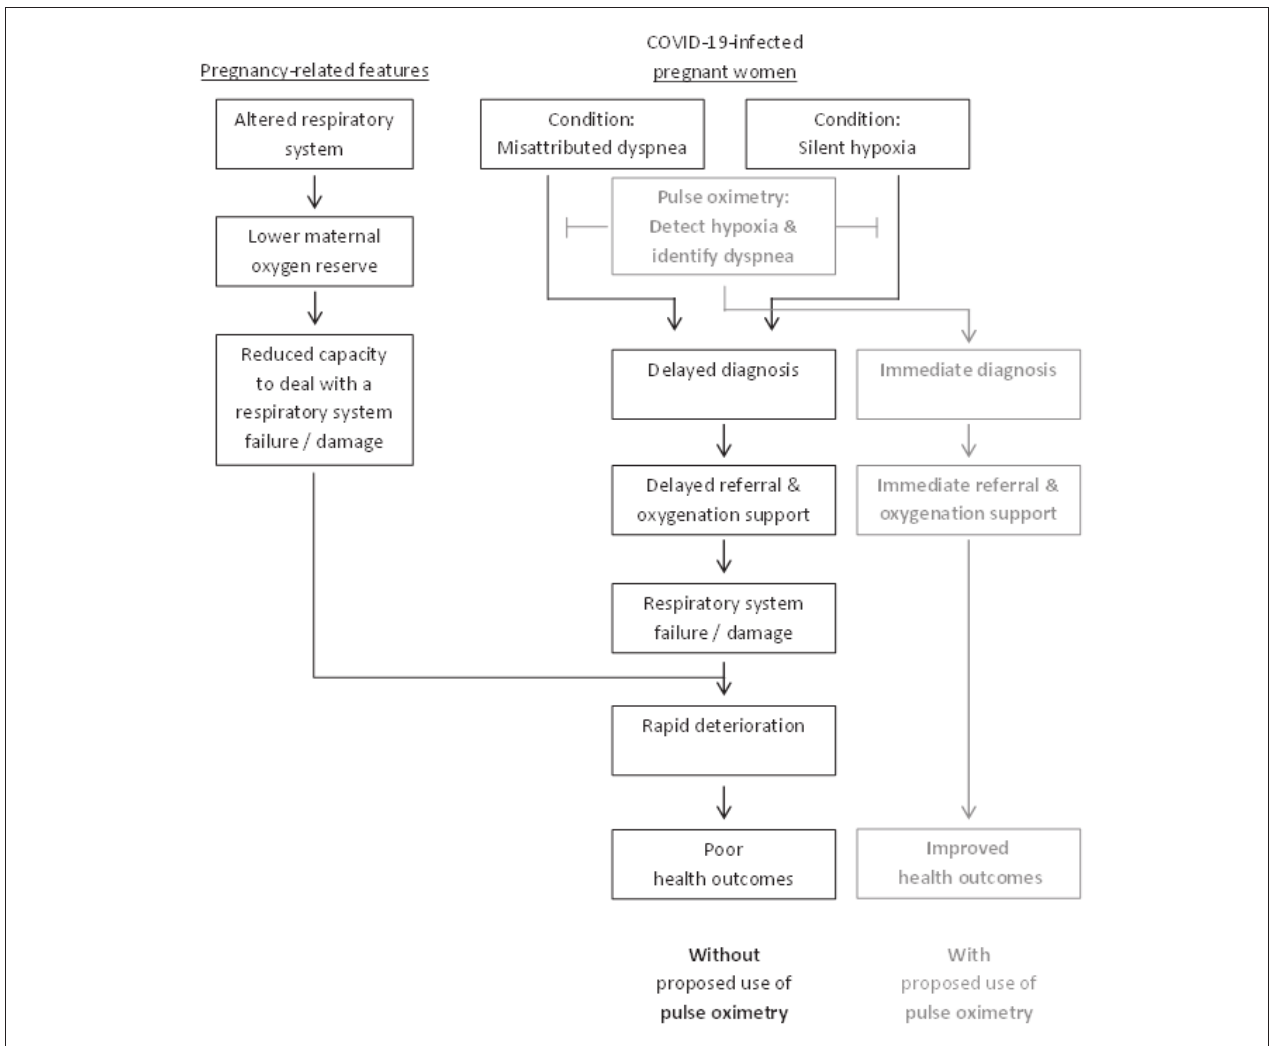
FIGURE 1 | Schematic representation of the conditions contributing to health outcomes in COVID-19-infected pregnant